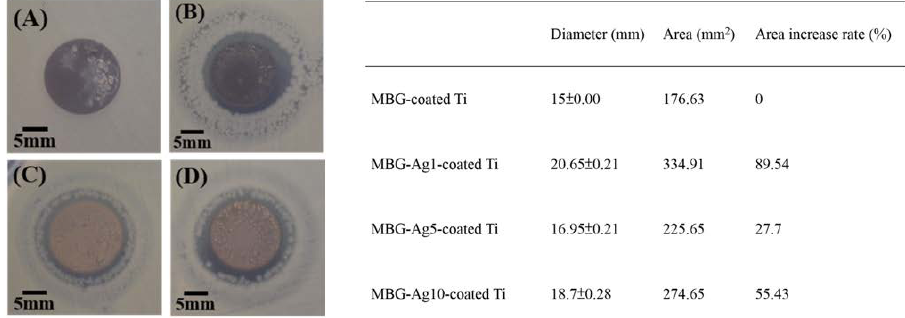
Figure 9. The inhibition zones of ( A ) MBG–coated Ti, ( B ) MBG–Ag1-coated Ti, ( C ) MBG–Ag5–coated Ti, and ( D ) MBG–Ag10–coated Ti against 10 7 CFU/mL Aggregatibacter actinomycetemcomitans .